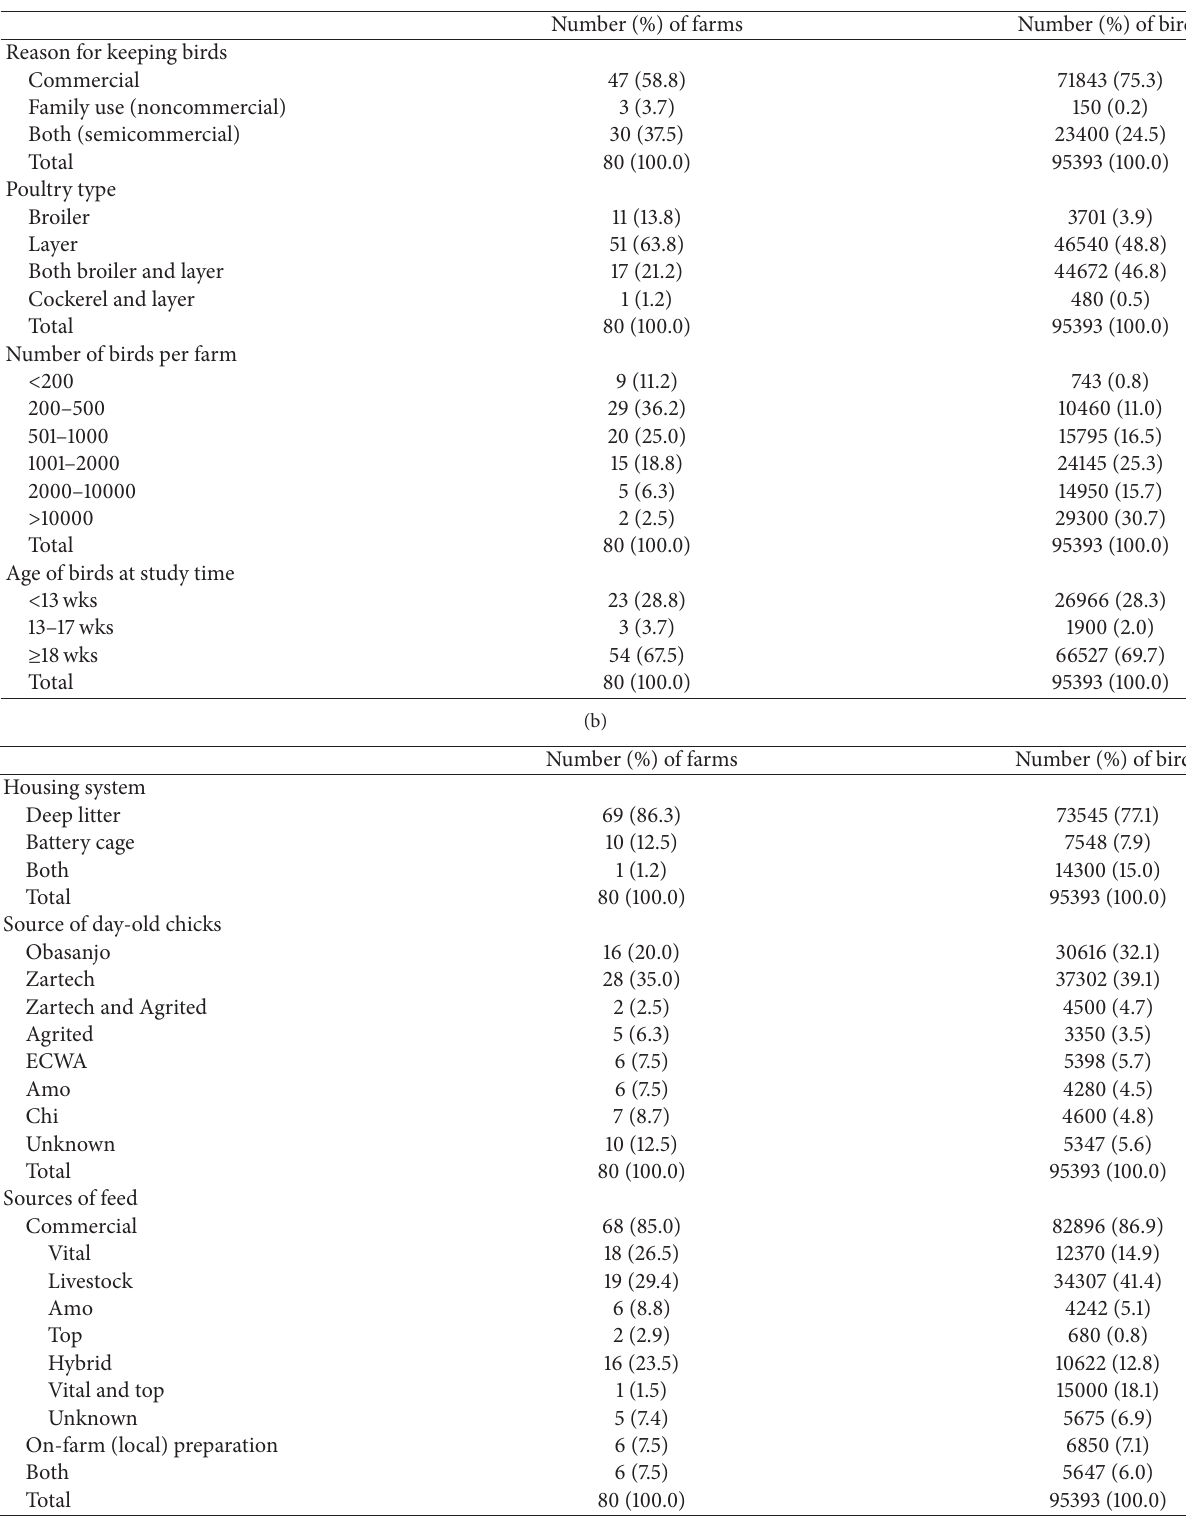
Table 1: (a) Number (%) of farms surveyed and birds involved with various reasons for farming, poultry type, stock size, and ages of birds. (b) Number (%) of farms and birds with various housing systems and sources of day-old chicks and